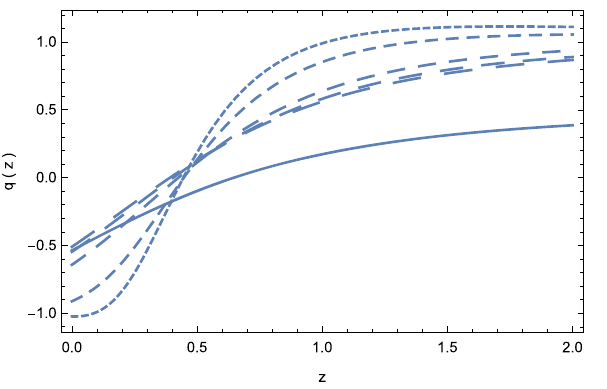
Fig. 7 Variationasafunctionoftheredshiftofthedecelerationparam- eter q ( z ) for the geometry-matter coupling function F for M = 0 . 98, and for different values of α : α = − 0 . 72 (dotted curve), α = − 0 . 77 (short dashed curve), α = − 0 . 80 (dashed curve), α = − 0 . 81 (long dashed curve), and α = − 0 . 82 (ultra-long dashed curve). To integrate the system of cosmological evolution equations we have used the initial conditions h ( 0 ) = 1, (cid:18)( 0 ) = 0 . 455, and (cid:4)( 0 ) = 0 . 335. The solid curve represents the evolution of the deceler- ation parameter in the standard (cid:4) CDM cosmological model